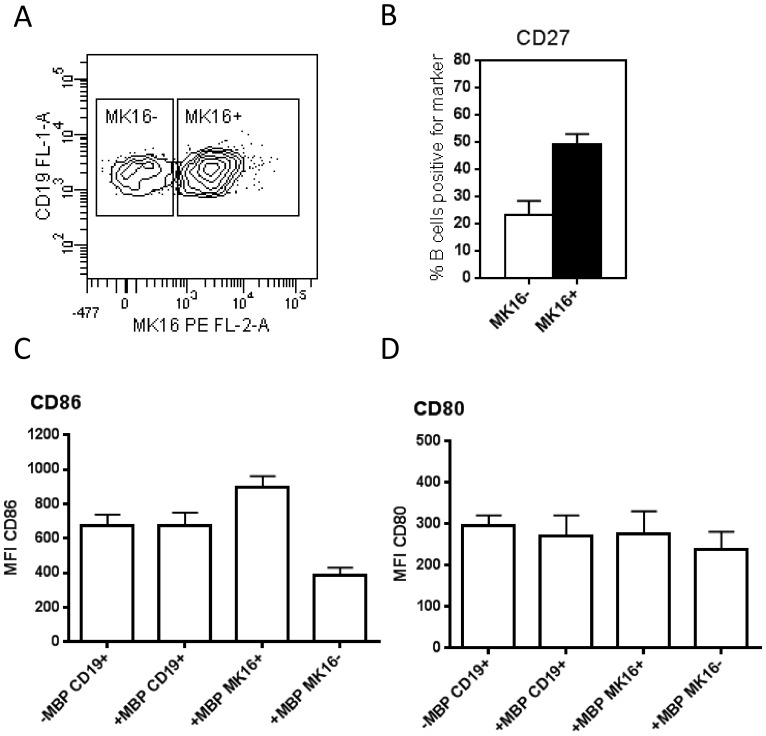
Phenotype of MBP85-99-presenting B cells.PBMCs from healthy HLA-DR15+ donors were incubated with MBP (30 µg/ml) in RPMI containing 30% (v/v) normal serum for 18 h. The presentation of MBP85-99 by CD19+ B cells was assessed using biotinylated MK16 and streptavidin-PE. A) Representative dot plot showing a subset of B cells that present MBP58-99 (MK16+) and a subset that do not (MK16−). Expression of various surface markers was evaluated in these subsets. B) The percentages of MK16+ (black bar) or MK16− (white bar) B cells expressing CD27 are shown (N = 4). B-cell expression of the co-stimulatory molecules C) CD86 and D) CD80 is shown as mean fluorescence intensity (MFI) values (N = 5). 7-AAD was used to exclude dead cells. Data are shown as means and SEM.